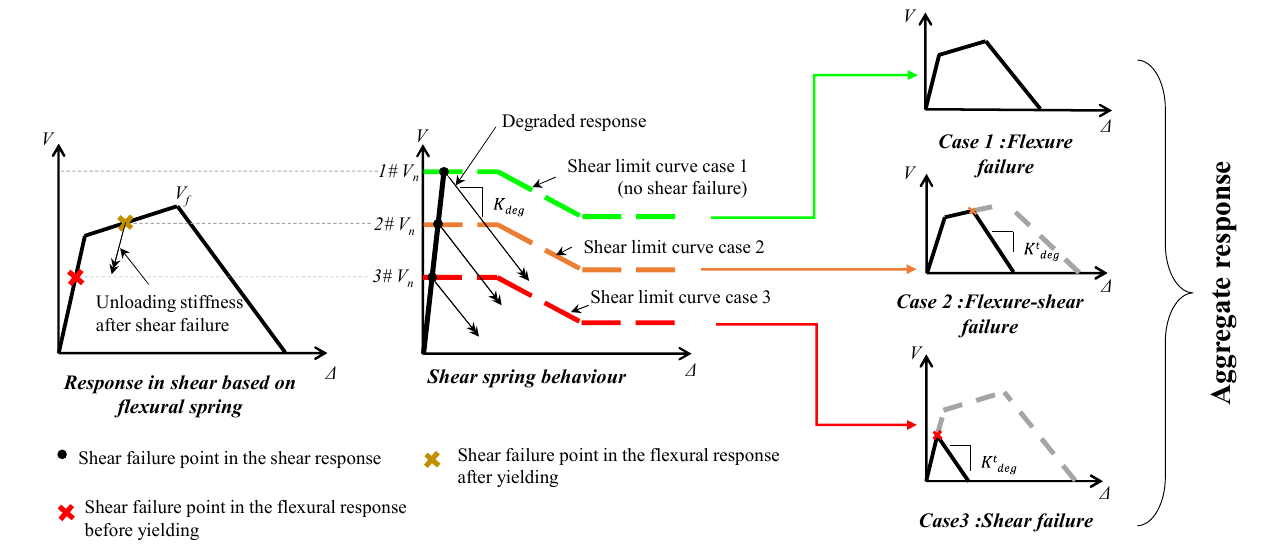
Figure 4. Modelling backbone adopted for the simulation of the pure flexural response spring (no shear spring associated)